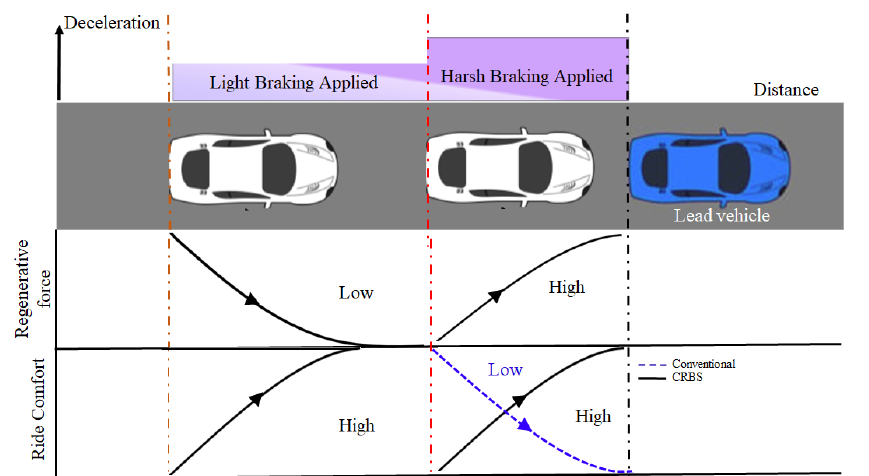
Figure 3. Ride comfort and efficiency improved with CRBS proposed